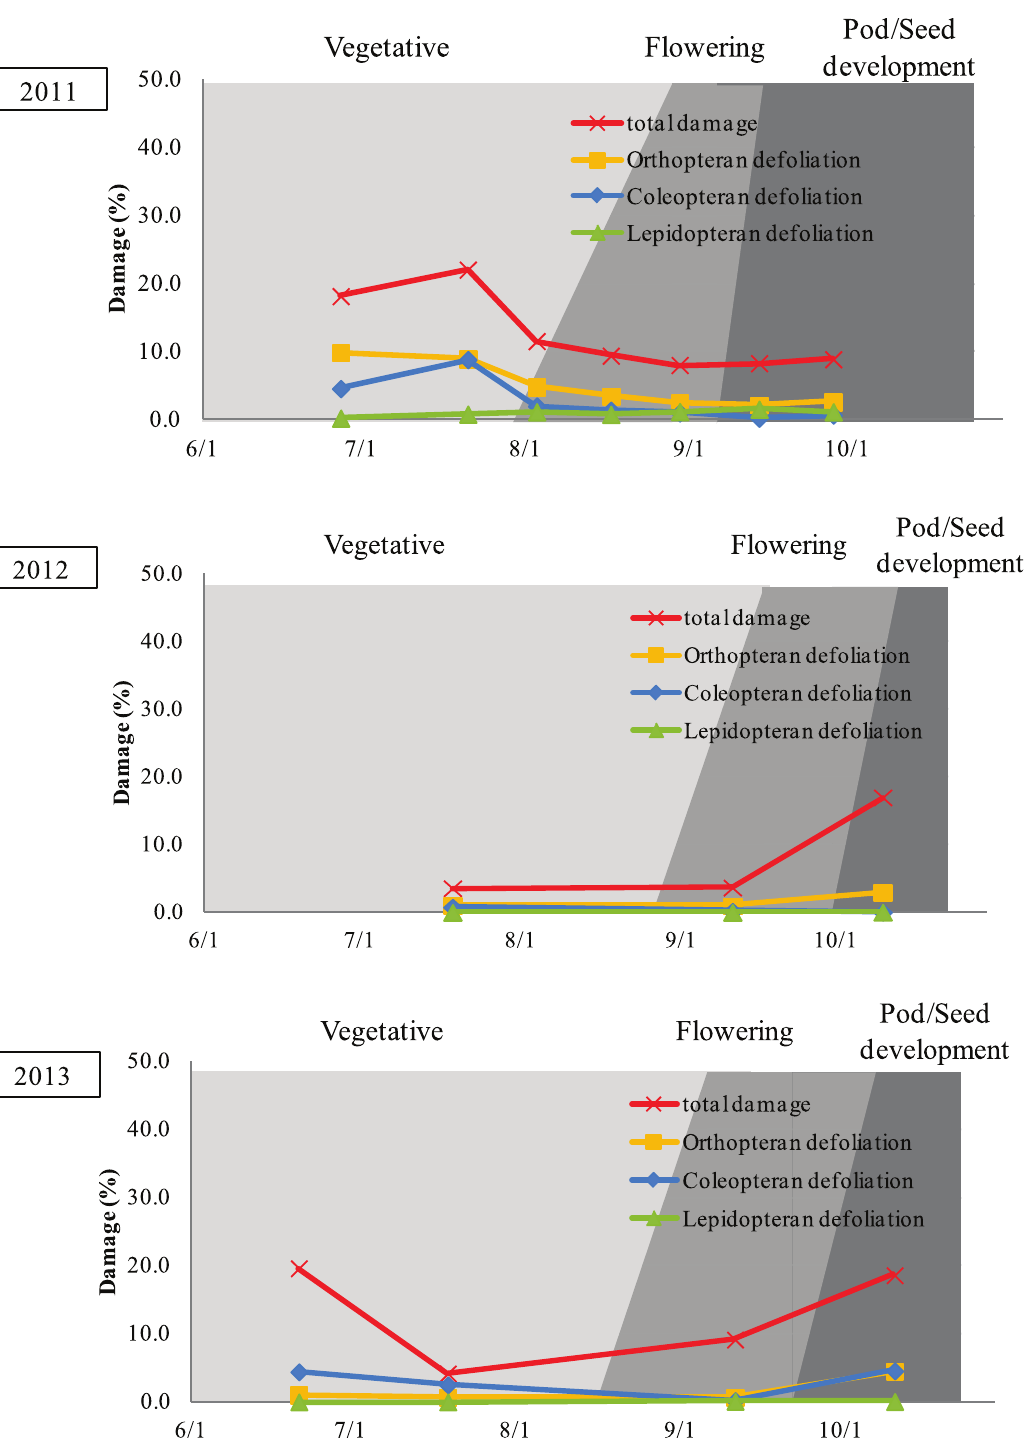
Fig 2. Observed level of defoliation by different insect taxa and the total insect damage by all organisms at Ibaraki in 2011, 2012, and 2013.